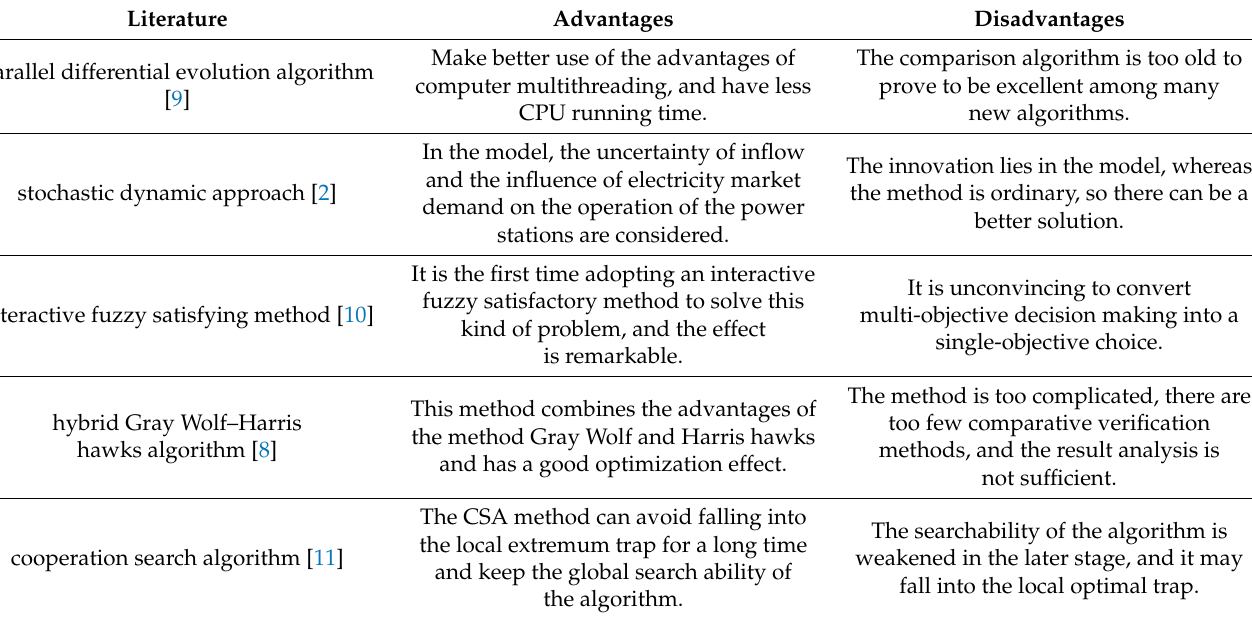
Table 1. Pros and cons of methods and models in the